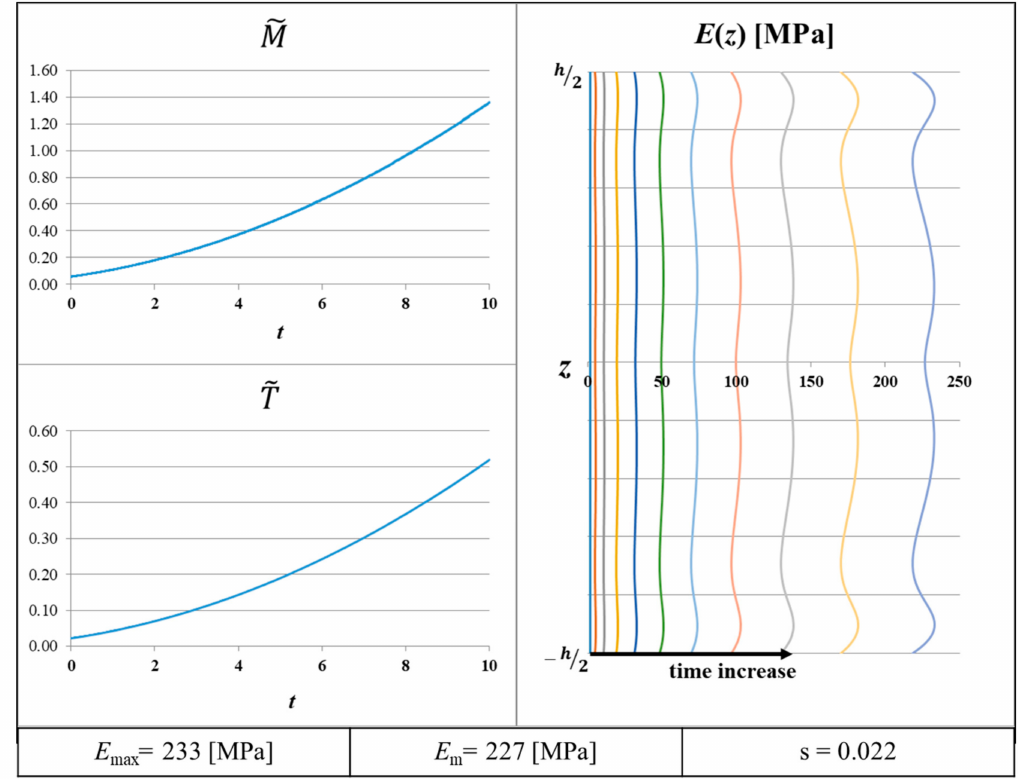
Figure 2. The optimal loading program and the resulting in-time Young’s modulus distribution along the height of the analyzed rectangular section, with parameters of